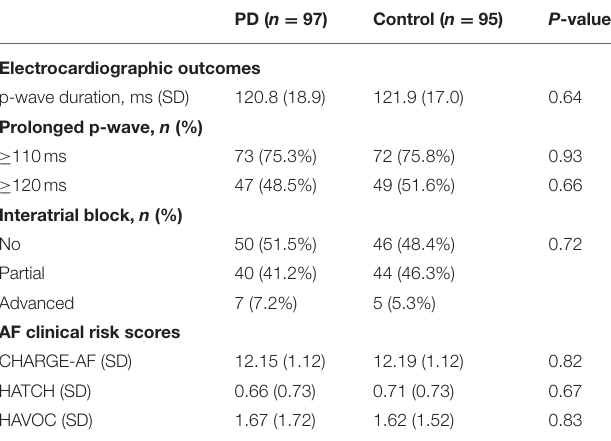
TABLE 1 | Baseline characteristics in Parkinson’s disease patients and age- and gender-matched controls.